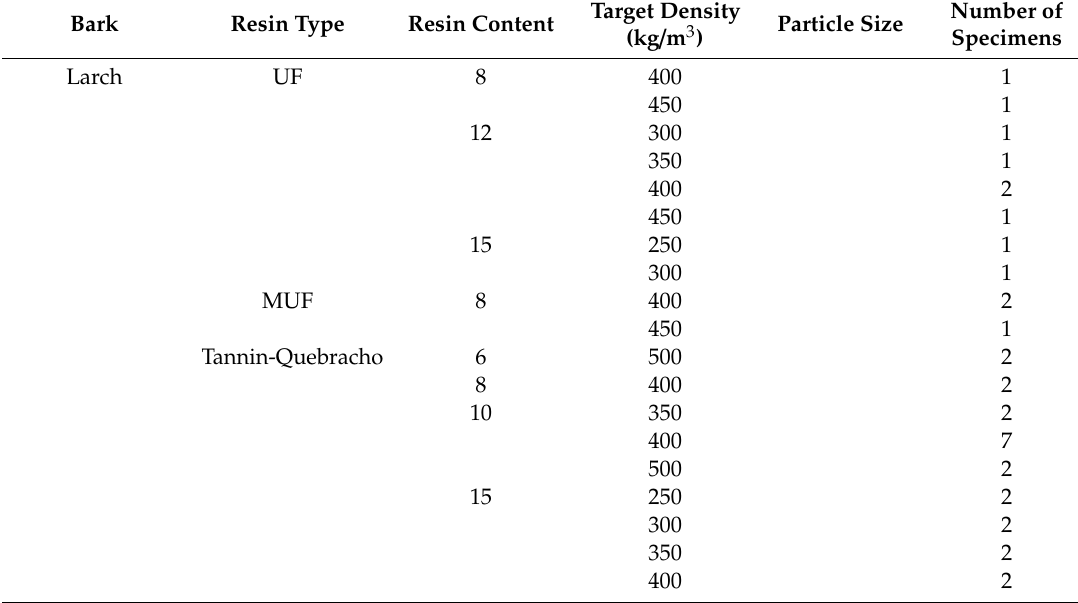
Table 2. Experimental design for bark insulation panels (larch and larch / popcorn).